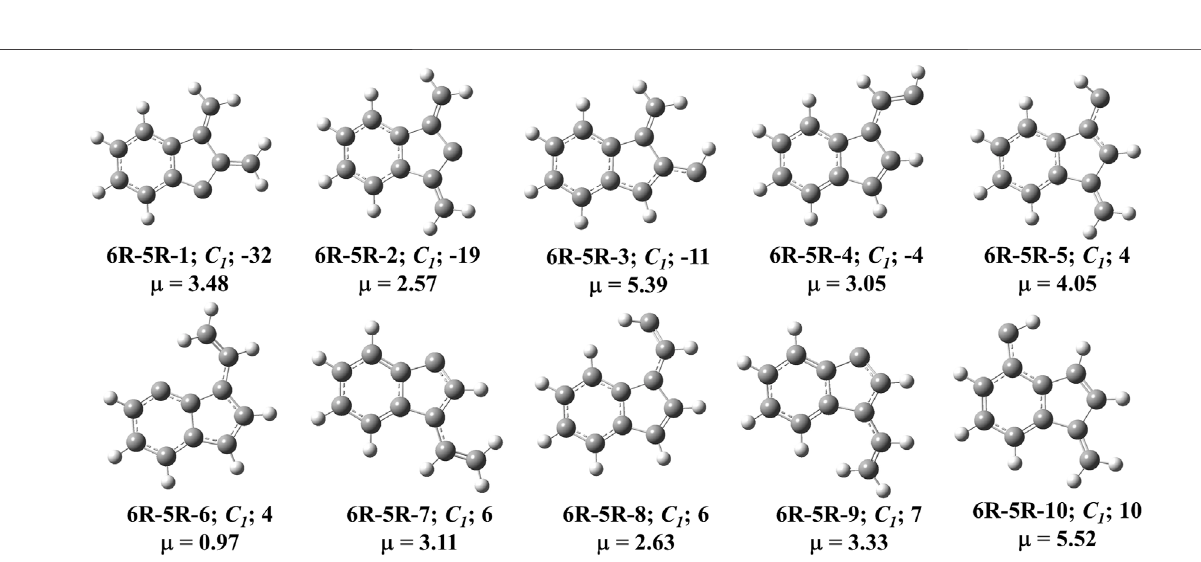
Frontiers in Physics |